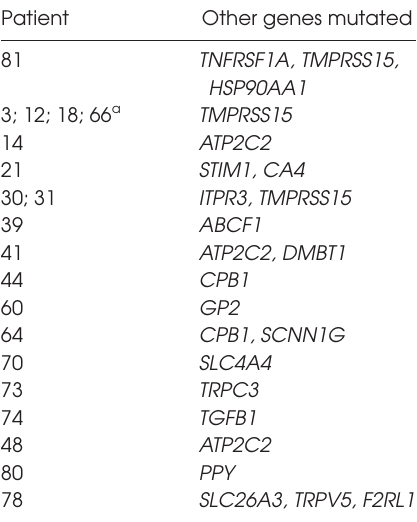
Table 5. List of patients with heterozygous variants only in genes involved in all other pancreatic pathways (3–6).